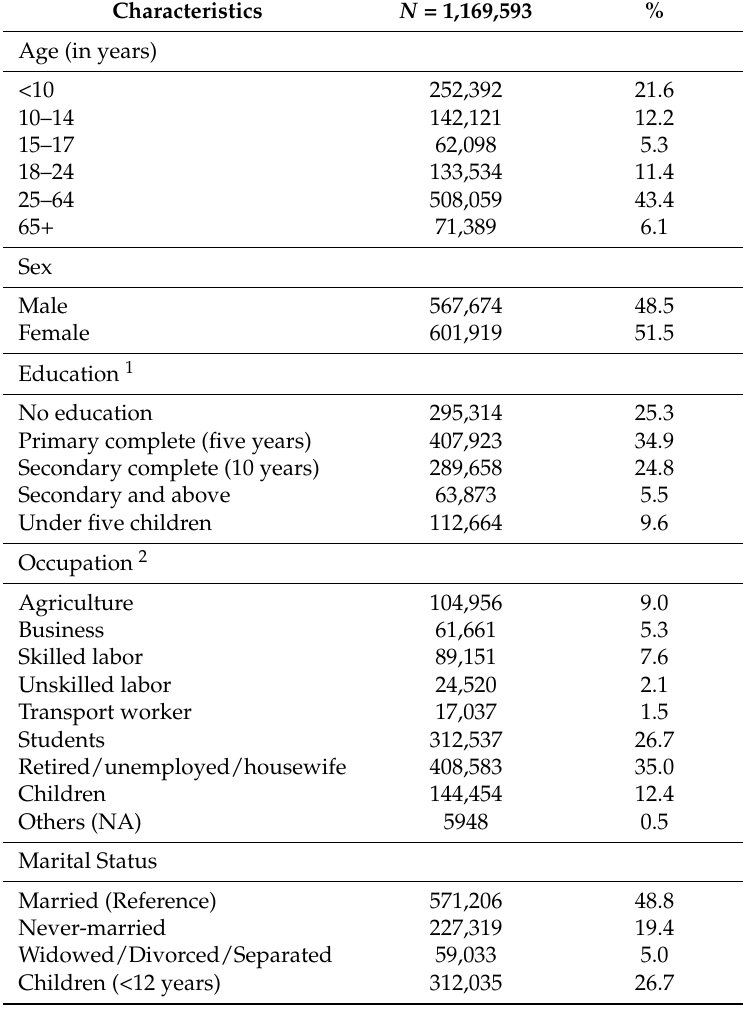
Table 1. Socio-demographic characteristics of the respondents.